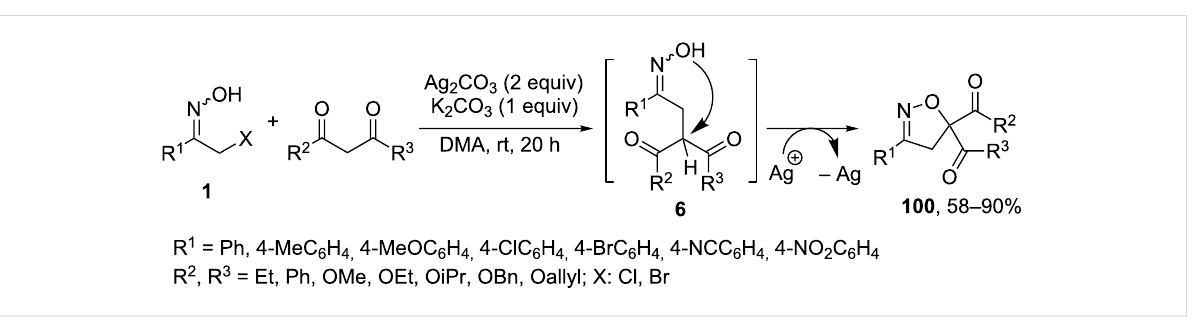
Scheme 37: Tandem Michael addition/oxidative cyclization strategy to isoxazolines 100